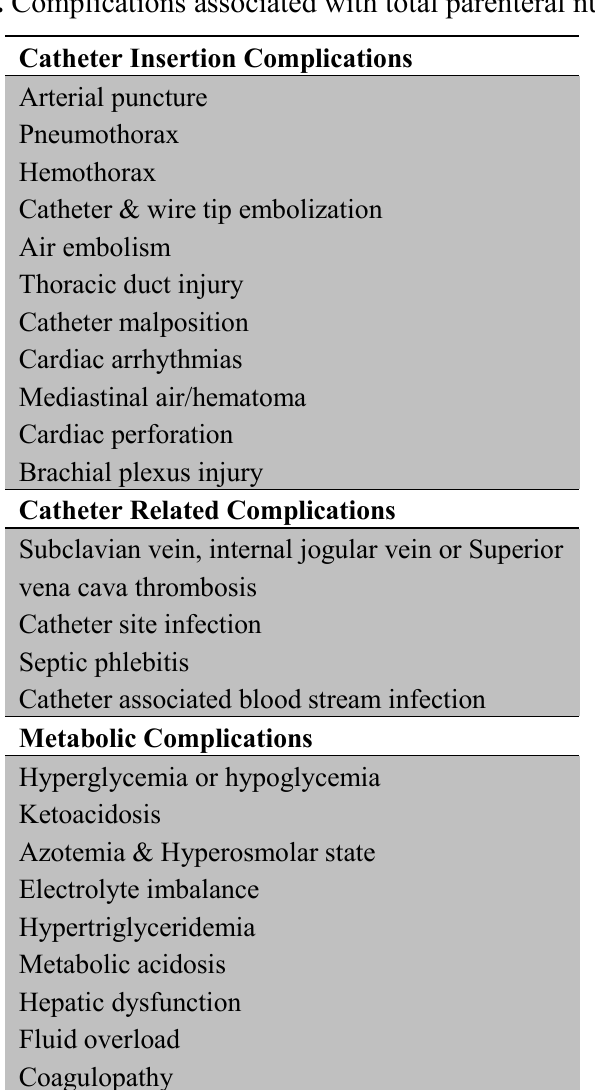
Table 3. Complications associated with total parenteral